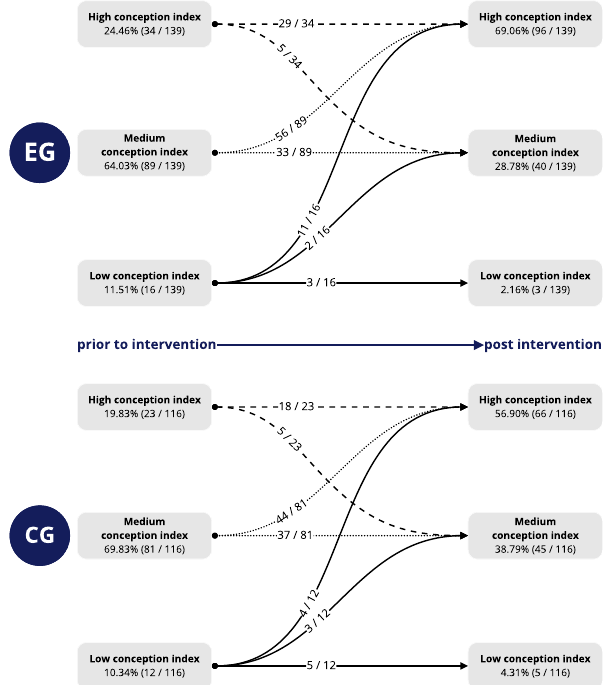
FIG. 11. Students ’ transitions between high HC, MC, and LC from pre- to post-test based on the students ’ results on the quantum physics ’ probability interpretation scale. It is shown how many students from each of the pretest groups HC, MC, and LC change to which group at the post-test point in time. For both survey time points, it is also indicates how many students are assigned to the three groups in total, both for EG and